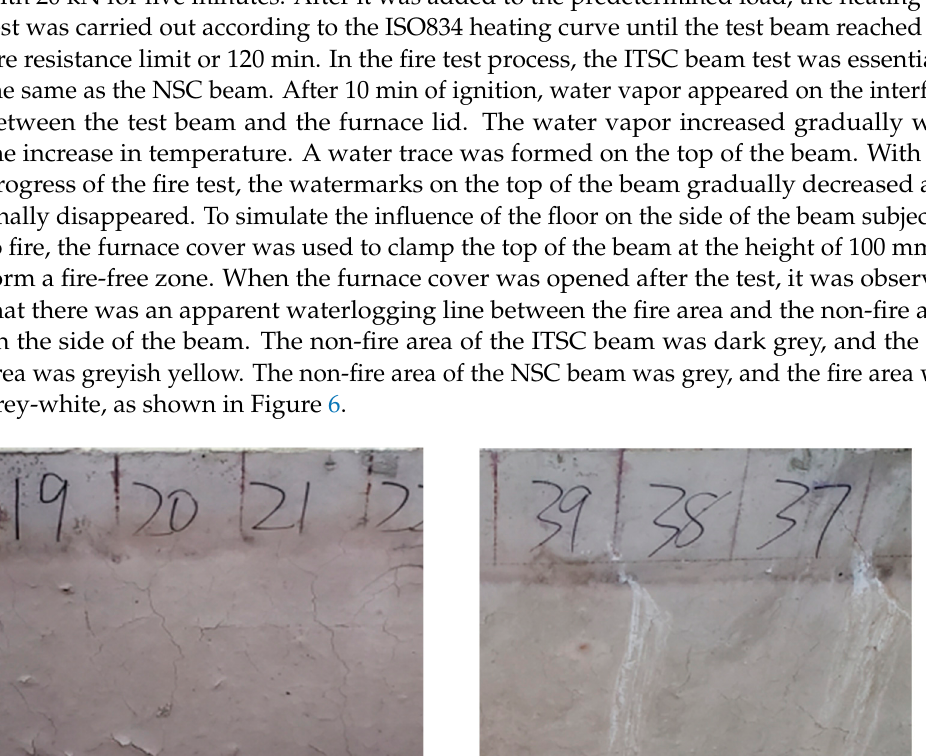
Figure 5. Arrangements of displacement transducers of beams: ( a ) Simply supported beam; ( b ) Continuous beam.